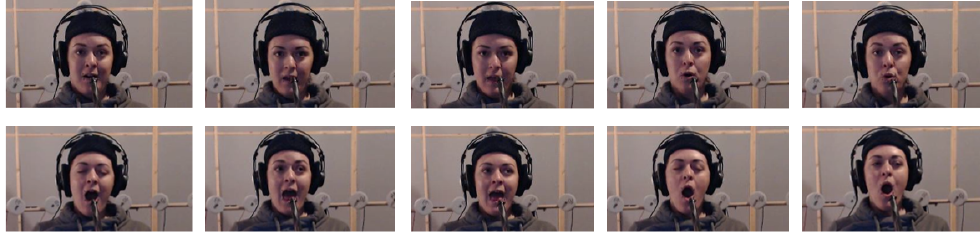
Figure 7. Exemplary mouth openings extracted from video for one female singer for the vowels /a:/, /e:/, /i:/, /o:/, /u:/ (left to right) at a 1 /A4/440 Hz in the top row and a 2 /A5/880 Hz in the bottom